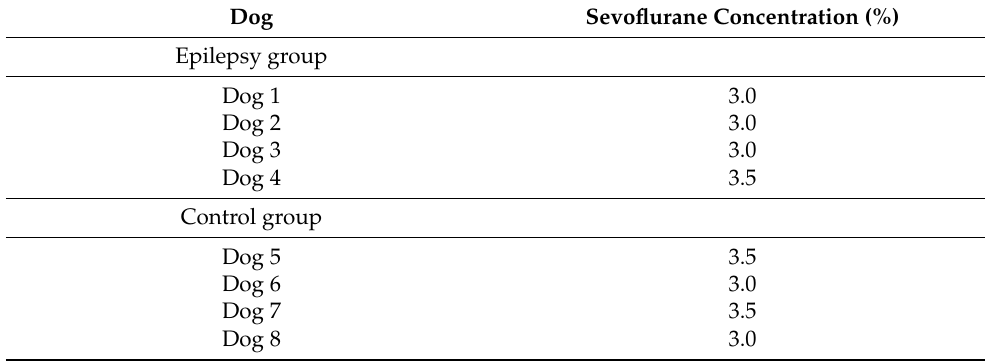
Table 6. Sevoflurane concentrations during baseline and activation periods in each